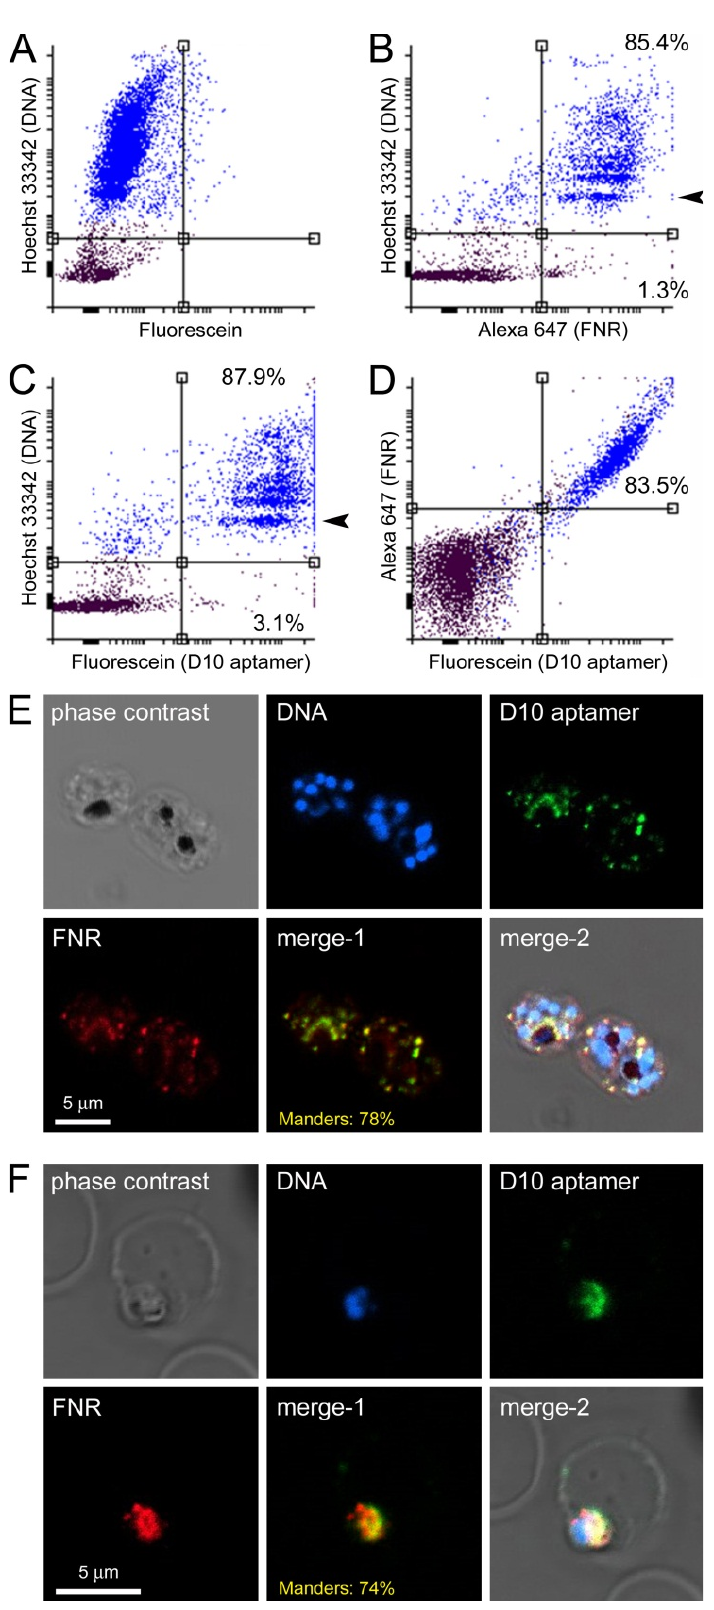
Figure 8. Colocalization study in P. falciparum of 6FAM-labeled D10 and FNR. ( A – D ) Flow cytometry analysis of ( B ) FNR, ( C ) D10, and ( D ) both molecules together. The axis scales indicate relative fluorescence arbitrary units. Panel ( A ) shows a control with Hoechst 33342 DNA staining only.